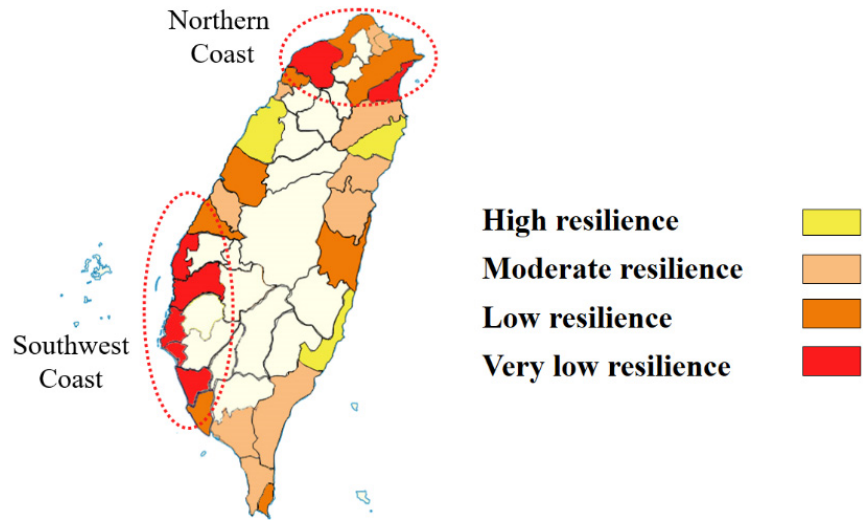
Figure 4. Overall Climate Disaster Resilience Index (CDRI) analysis of coastal regions. While the CDRI results indicated a greater degree of diversity in the institutional